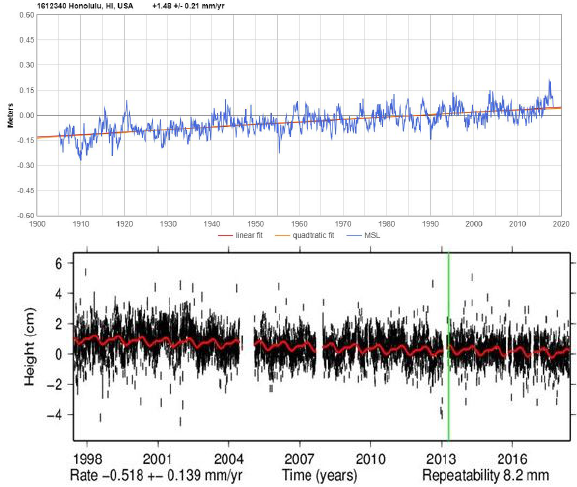
According to NGL, in DUND w